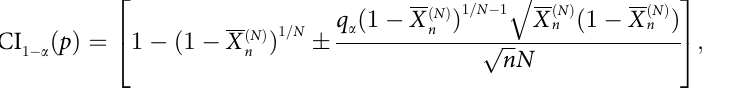
ffiffiffiffiffiffiffiffiffiffiffiffiffiffiffiffiffiffiffiffiffiffiffiffiffiffiffiffiffi